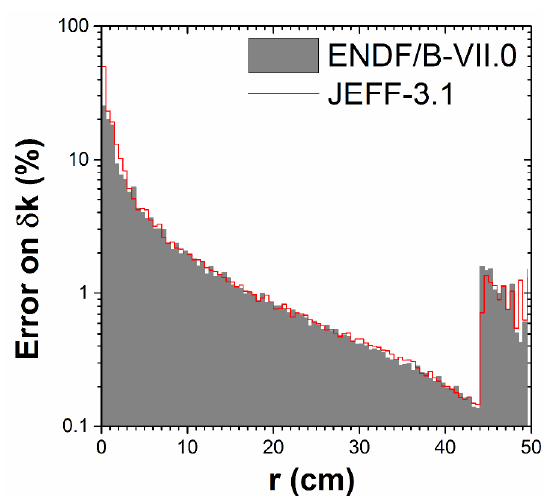
Figure 5. Evolution with r of the statistical relative errors on the k eff perturbation values at n =